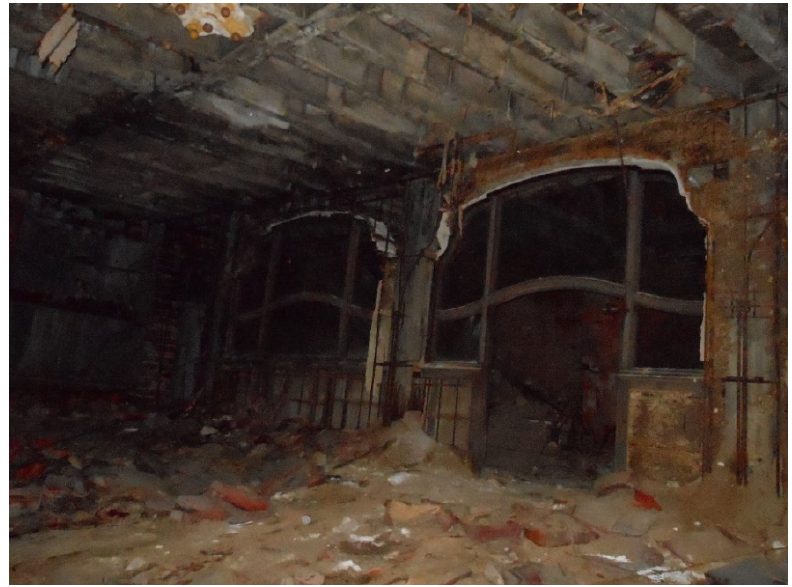
Figure 2. The Palace Theater Lobby, Gary, Indiana (Photo courtesy of Ball State University undergraduate architecture student Shannon